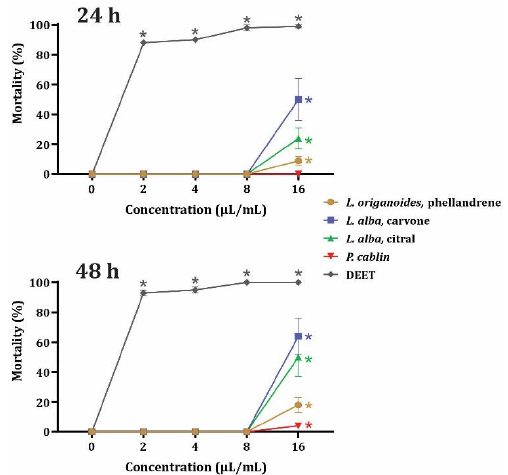
Figure 1. Percentage mortality of U. dermestoides adults exposed to EOs from phellandrene-rich L. origanoide , carvone-rich L. alba , citral-rich L. alba , and P. cablin, after 24 and 48 h exposures. Data (n = 8) are presented as mean ± SEM. *. Significant difference compared to the negative